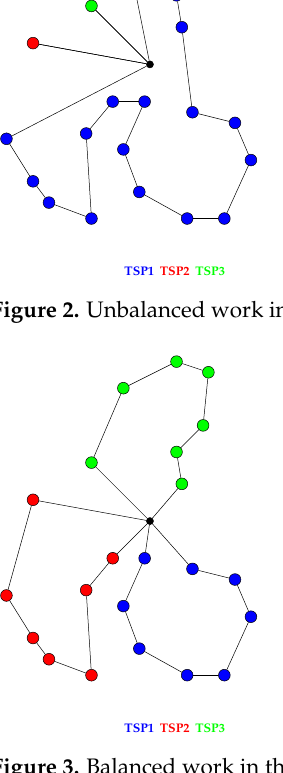
Figure 3. Balanced work in the